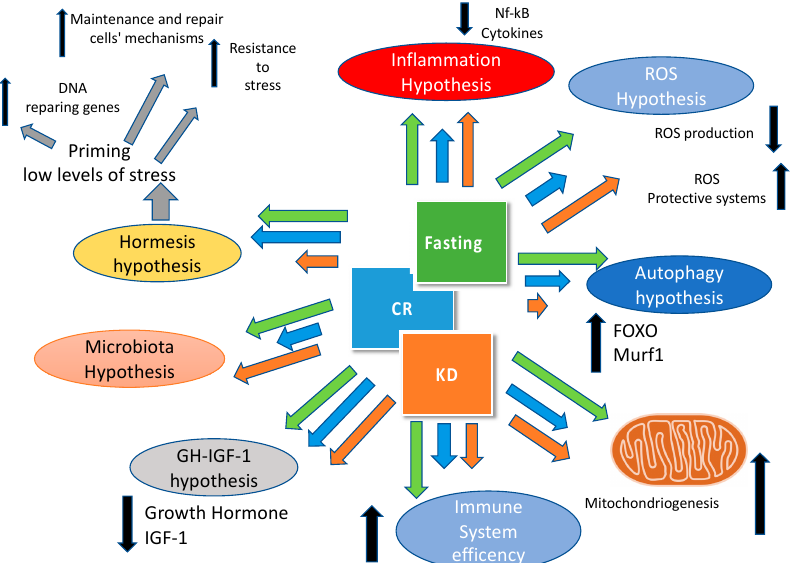
Figure 2. Mechanisms involved in health effects of the ketogenic diet (KD), caloric restriction (CR), and fasting. The size of the arrows is related to the relative effect of KD (orange), CR (blue), and fasting (green) on the different pathways involved (IGF-1: insulin-like growth factor-1; Murf2: Muscle-specific RING finger-2; Nf-kB:nuclear factor kappa-light-chain-enhancer of activated B cells).